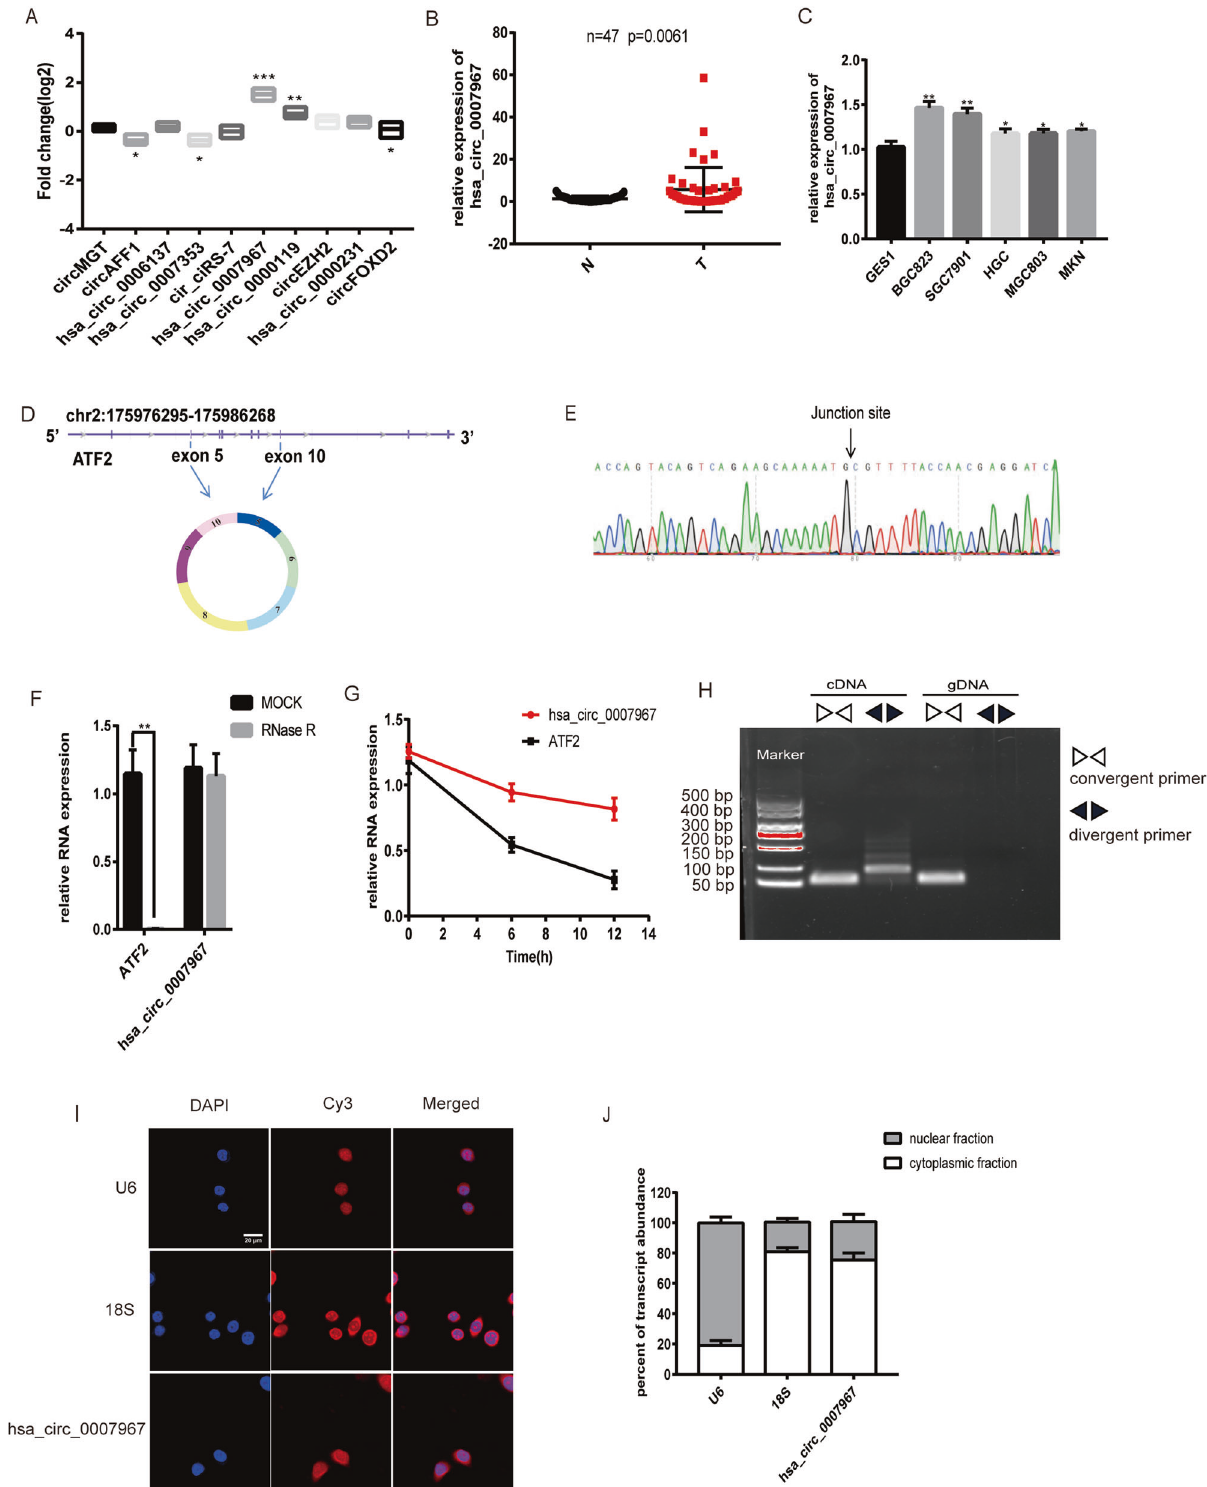
Fig. 1 Identi fi cation and characterization of hsa_circ_0007967. A Expression of fi ve most upregulated and downregulated circRNAs in fi ve paired GC tumors and normal tissues. B Expression of hsa_circ_0007967 in 47 pairs of GC tissues and normal tissues. C Expression of hsa_circ_0007967 in GC cell lines and normal gastric epithelial cell line. D The location of hsa_circ_0007967 in chromatin and its structure. E Sanger sequencing con fi rming the back splicing junction site. F The RNase R digestion assay suggesting hsa_circ_0007967 is resistant to RNase R. G The use of act-D (1 μ g/ μ l) demonstrating that hsa_circ_0007967 is stable than its linear form. H Northern blotting of hsa_circ_0007967 and its linear form in cDNA and gDNA ampli fi ed by convergent and divergent primers. I Location of hsa_circ_0007967 in BGC823 cells detected by FISH. J QPCR analysis of nuclear and cytoplasmic fractions conforming that hsa_circ_0007967 is located in cytoplasm. Cell Death Discovery (2022)